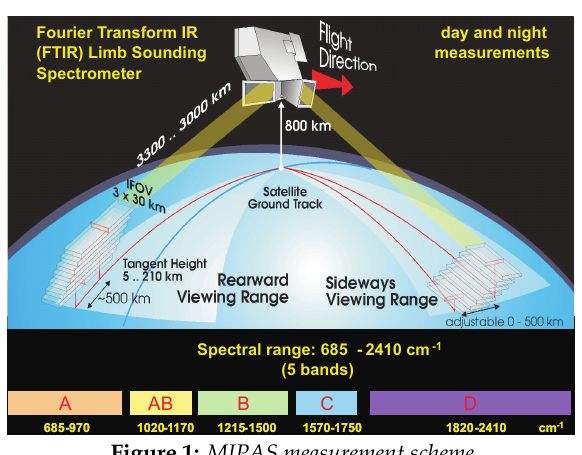
Figure 1: MIPAS measurement scheme